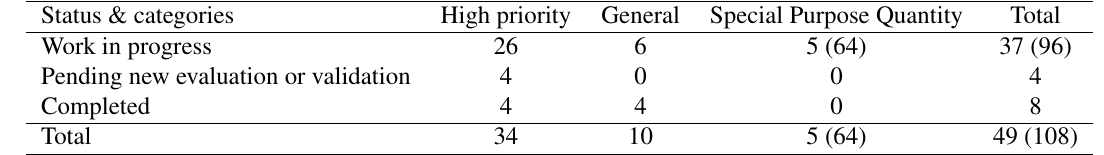
Table 1. Number of requests vs. categories and status. The values between parentheses are for individual requests in the SPQ category.